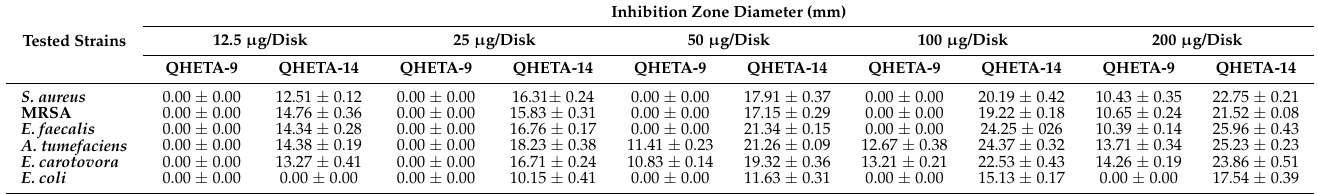
Table 3. Different minimum inhibitory concentrations of QHETA-9 and QHETA-14 against the tested bacterial